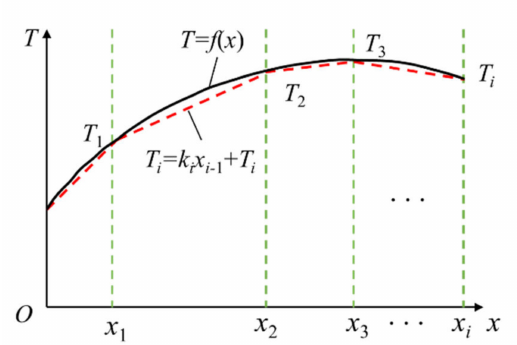
Figure 4. The piecewise linear interpolation